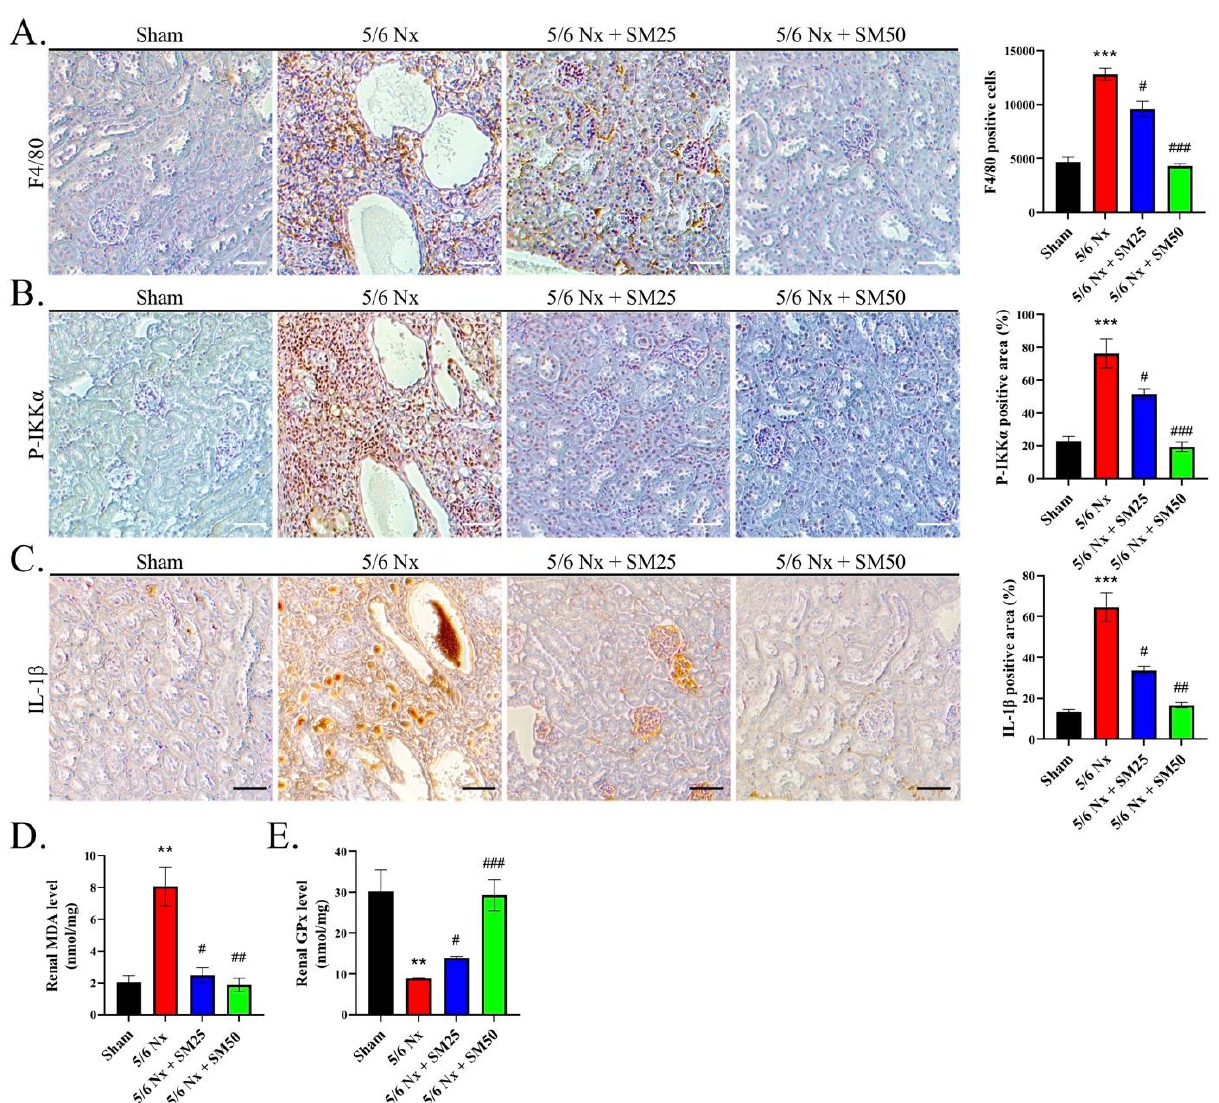
Figure 2. SM reduces the infiltration of macrophages and inhibits the ROS-induced secretion of IL- 1β in the kidneys of ApoE −/− 5/6 Nx mice. ( A ) Expression of F4/80 macrophages, ( B ) P- IKKα expression, and ( C ) IL- 1β expression , as indicated by immunohistochemistry (IHC) staining; scale bar = 100 μ m. Quantification of renal ( D ) MDA and ( E ) GPx levels in the kidneys of 5/6 Nx mice. Data are expressed as the mean ± SEM ( n = 6). ** p < 0.01, *** p < 0.001 vs. sham group. # p < 0.05, ## p < 0.01, ### p < 0.001 vs. 5/6 Nx group.